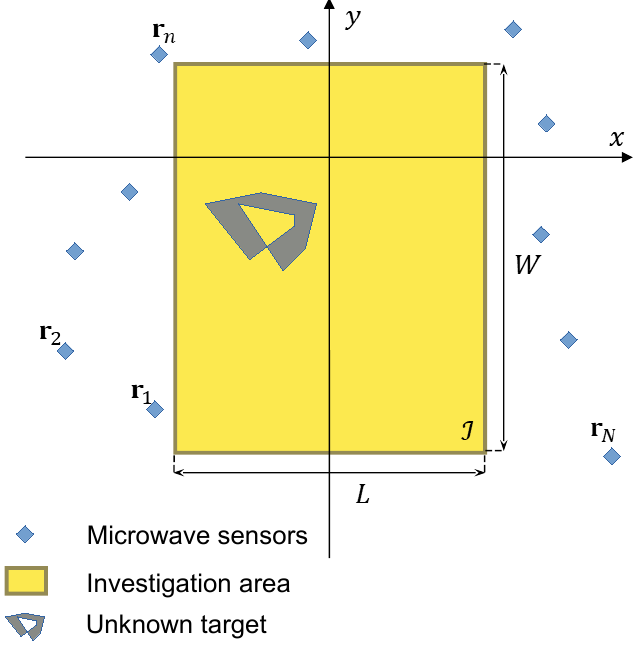
Figure 1. Microwave sensor network for characterizing dielectric targets: sketch of the adopted problem